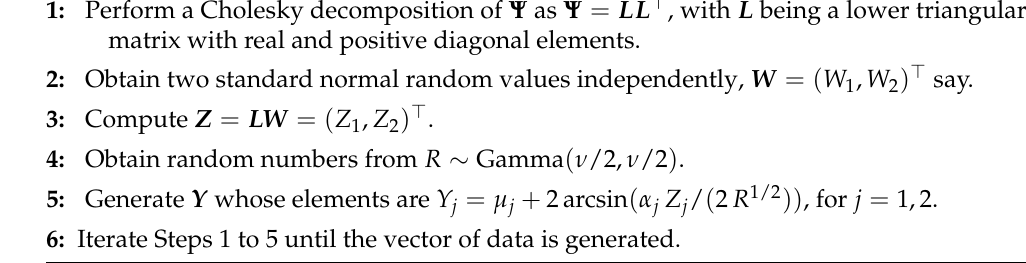
Algorithm 2 Generator of bivariate log-BS- t random